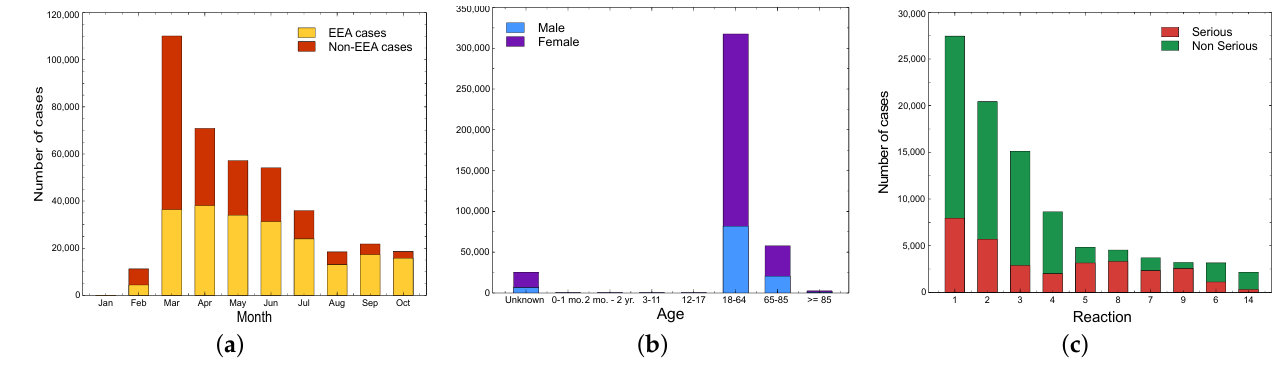
Figure 5. Main results of pharmacovigilance for Janssen vaccine: number of reports received over time ( a ), and their distribution by age group and sex ( b ) and by seriousness ( c ). The notification rate is highest in the age group 18–64 years (about 84% of cases) and decreases in older age groups and the very young. In addition, 58% of reports involve women, 41% men, and in 1% of cases, sex is not specified (see Figure 5b). Most of the notifications refer to the general disorders and administration site condi- tions category (26%), followed by nervous system disorders (20%), musculoskeletal and connective tissue disorders (15%), and gastrointestinal disorders (8%). In 66% of cases, reports were entered as non-serious and in 34% as serious (see Figure 5c). The outcomes of these events are reported in Table 5 as follows: 33% “Recovered/Resolved” , 29% “Not recovered/Not resolved” , 21% “Recovering/Resolving” , 15% “Unknown” , and 1% “Fatal” . Table 5. Outcome of reports of suspected major adverse events related to Janssen vaccine after 17 million doses administered